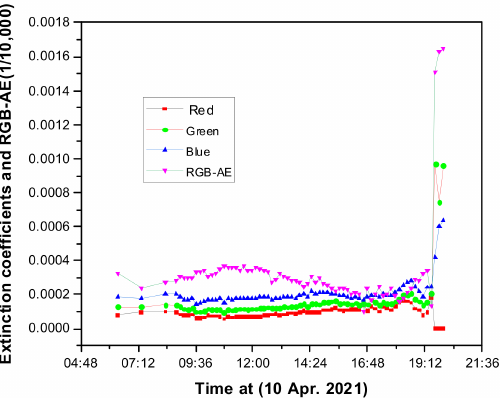
Figure 10. Extinction coefficients and AE value variation measured during the daytime.